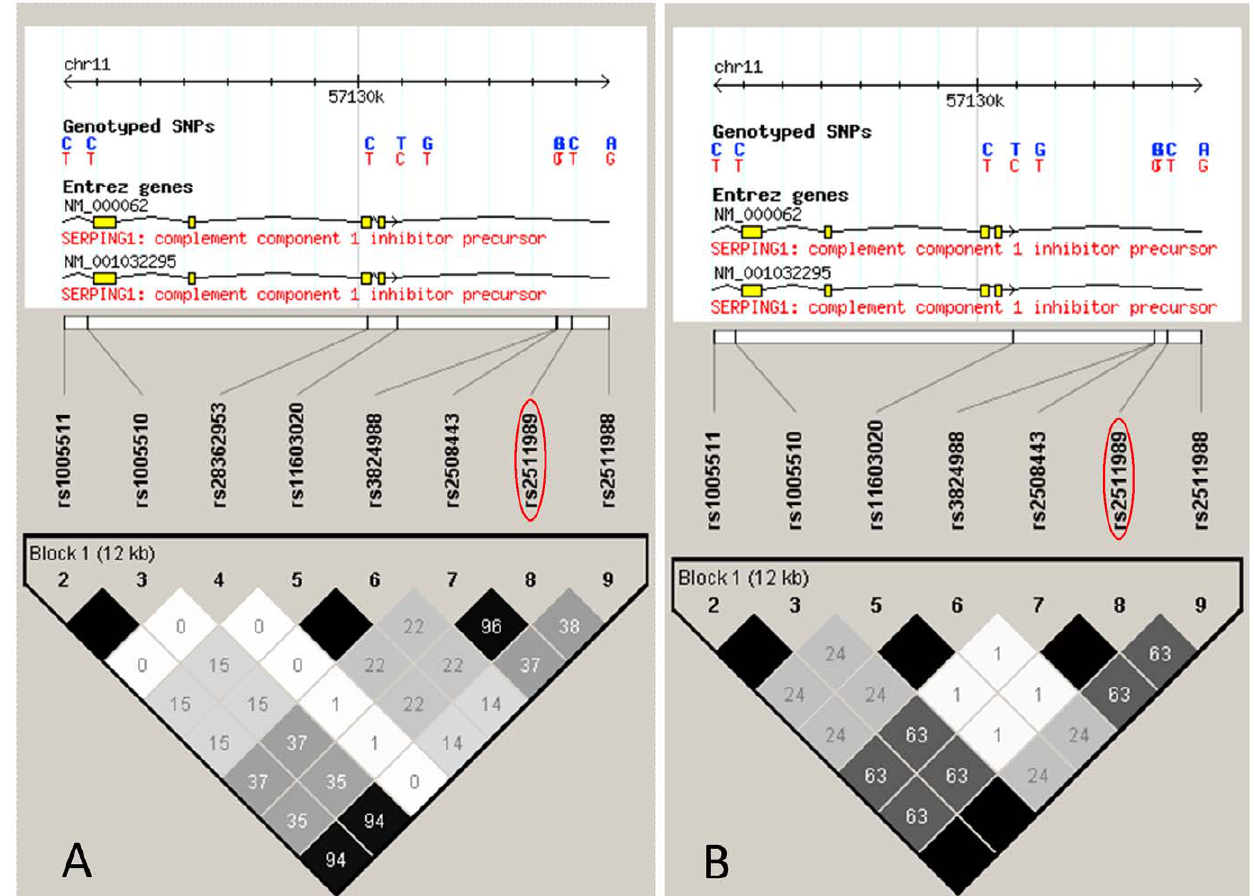
Figure 1. Linkage disequilibrium (LD) structure across the complement component 1 inhibitor ( SERPING1 ) gene in Caucasian and Japanese populations. Genotype data were retrieved from HapMap CEU (Utah residents with ancestry from northern and western Europe; A) and JPT (Japanese in Tokyo, Japan; B) data sets. Haplotype blocks were determined using the ‘‘four-gamete rule’’ option in Haploview; all HapMap single nucleotide polymorphisms on SERPING1 gene are in the same block in both populations. Each box provides estimated statistics of the coefficient of determination (r 2 ), with darker shades representing stronger LD. doi:10.1371/journal.pone.0019108.g001 PLoS ONE |